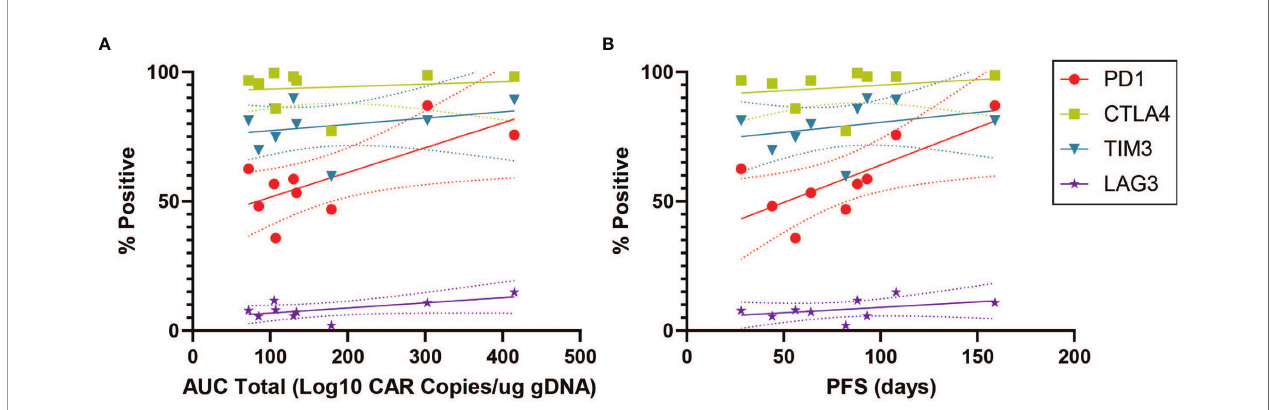
FIGURE 4 | PD1 Correlations for CD4 + CAR - Cells in Patient Transduction Products. Correlation of PD1 expression with clinical outcomes for CD4 + CAR - cells in patient transduction products. (A) Association between PD1 expression and total AUC. (B) Association between PD1 expression and PFS. Error bars shown are 95% con fi dence intervals.